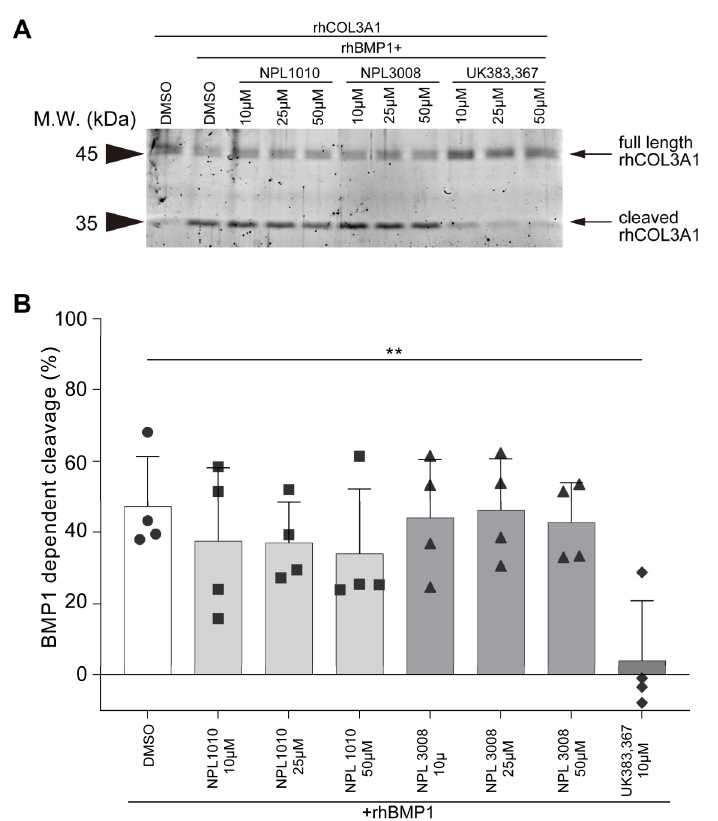
Figure 6. NPL1010 and NPL3008 rarely inhibit BMP1-dependent COL3A1 cleavage. ( A ) COL3A1 cleavage assay. rhCOL3A1 was incubated with rhBMP1. The effects of NPL1010 and NPL3008 on BMP1-dependent rhCOL3A1 cleavage were analyzed using SDS–PAGE and Oriole staining. Arrows indicate full-length rhCOL3A1 and cleaved rhCOL3A1. ( B ) Statistical analysis of BMP1-dependent cleavage of COL3A1. The levels of noncleaved and cleaved COL3A1 were measured by performing densitometry of the Oriole-stained gel, and the percentage of cleaved COL3A1 was calculated based on the fragments detected at each molecular weight and background. **: p < 0.01 (Dunnett’s test). The error bar indicates +s.d. with individual data shown ( n = 4).